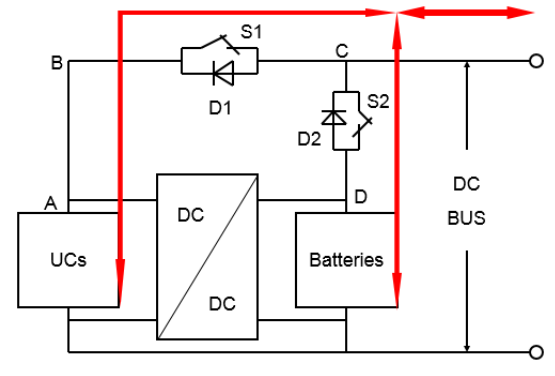
Figure 6. Energy flow in Mode III.